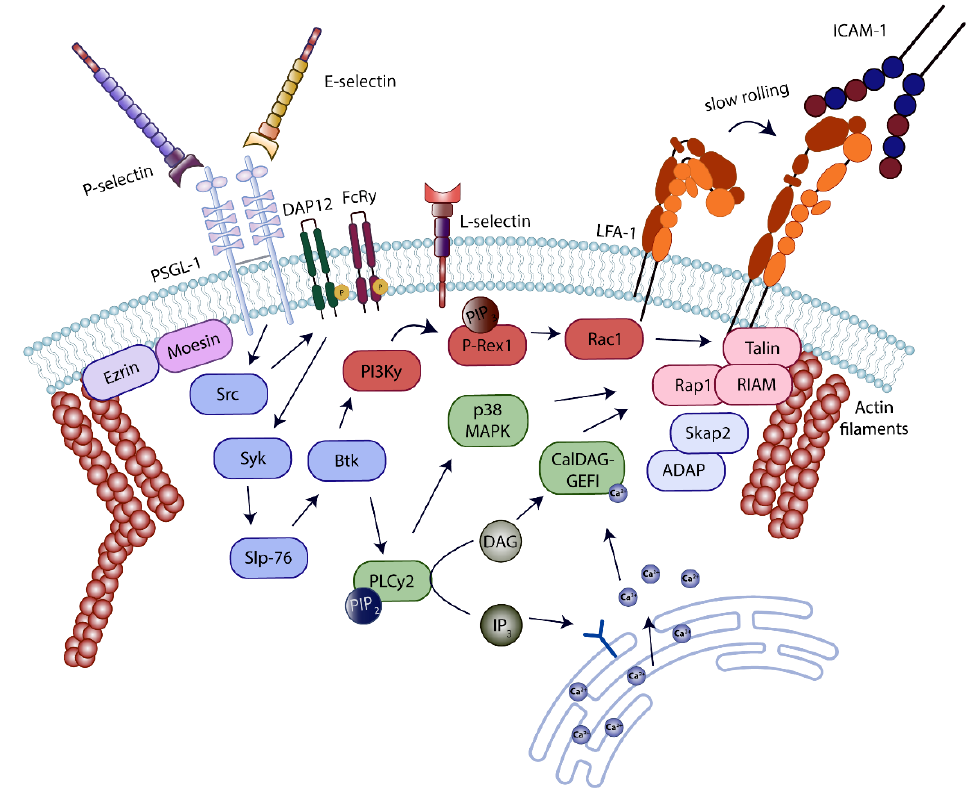
Figure 3. Inside-out signaling cascade in neutrophils induced by selectin–ligand binding. Selectin- binding to P-selectin glycoprotein ligand-1 (PSGL-1) on the neutrophil surface, elicits a specific intracellular signaling pathway resulting in affinity activation of lymphocyte-function-associated antigen-1 (LFA-1). Downstream of selectin-PSGL-1-ligation, several signaling molecules